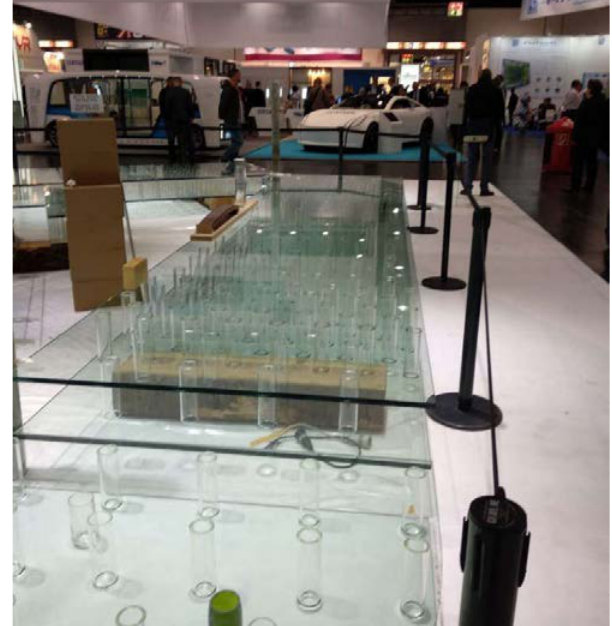
Fig. 15 Full size panel at glasstec 2018.